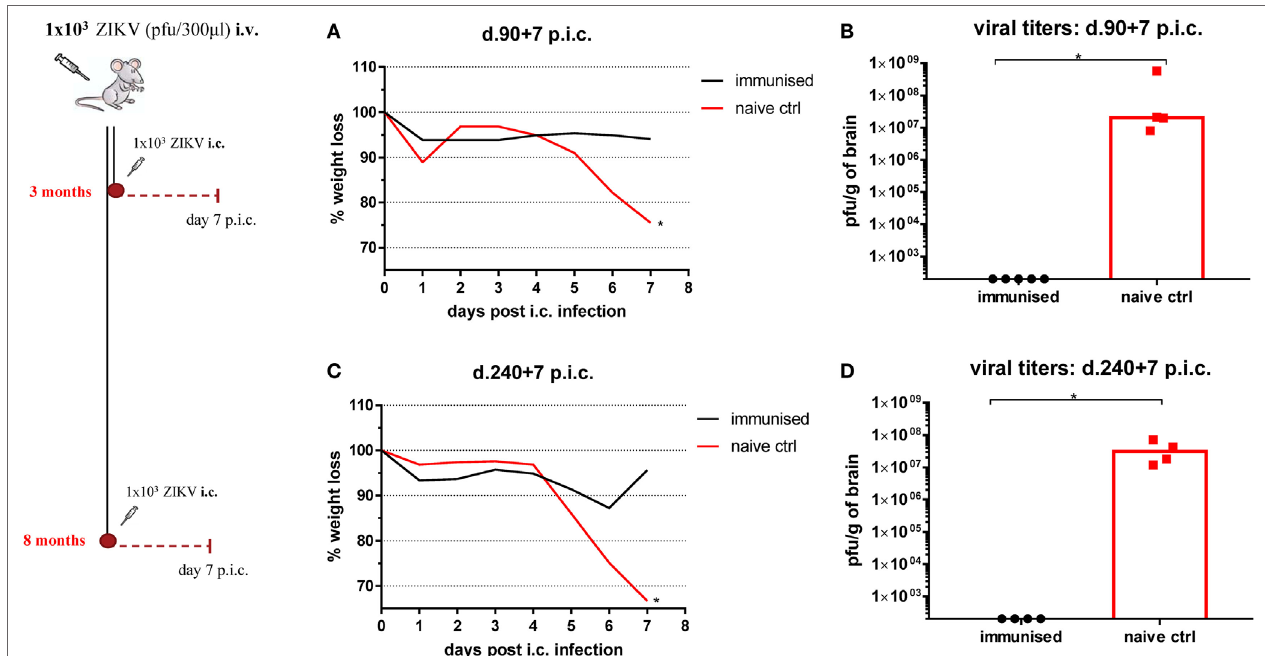
FigUre 7 | Longevity of protection. Wild-type C57BL/6 mice were inoculated with 1 × 10 3 pfu Zika virus (ZIKV) i.v. and 3 (a,B) or 8 (c,D) months post i.v. inoculation mice were challenged with 1 × 10 3 pfu ZIKV i.c. Mice were weighed and monitored daily (a,c) , and on day 7 post i.c. challenge, brains were removed and viral titers were measured by a plaque assay (B,D) . Mice were weighed and monitored daily, and on day 7 post i.c. challenge, brains were removed and viral titers were measured by a plaque assay. Groups of naïve mice were used as negative controls. The detection limit for virus in brain was 250 pfu/g organ. Each dot represents an individual animal, and bars represent the medians of the groups. The weight curves depict the group medians. n = 4–5 mice/group, * p < 0.05. Similar results were obtained in BALB/c mice (see Figure S2 in Supplementary